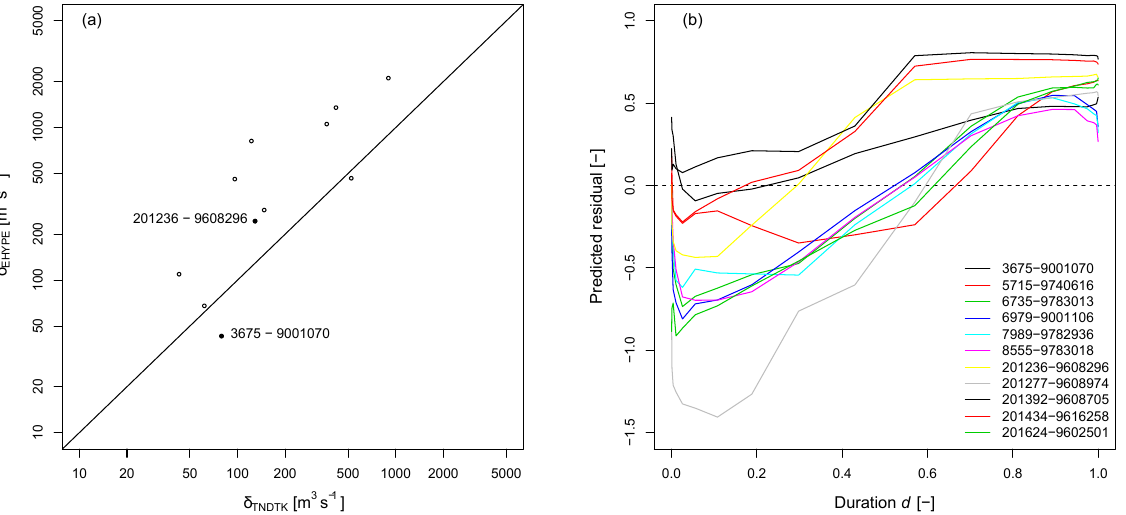
Figure 7. 11 E-HYPE prediction nodes: (a) comparison between TNDTK ( x axis) and E-HYPE ( y axis) in terms of distances δ s between empirical and predicted FDCs; the 1 : 1 line represents equivalent performance for TNDTK and E-HYPE; (b) standardized residual–duration curves computed as illustrated in Eq. (8) (TNDTK streamflow quantiles are used for standardization).